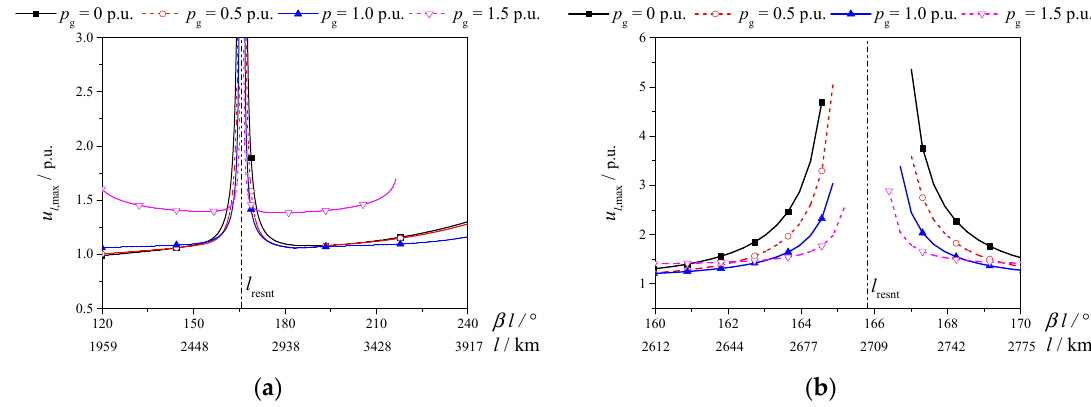
Figure 3. The maximum voltage along the whole line for different transmission distances. ( a ) β l in the range of 120°–240°; ( b ) β l in the range of 160°–170°.